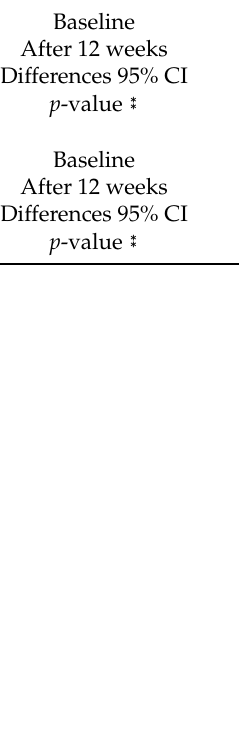
Table 2. Comparison of atherogenic indicators before and after of the trial.